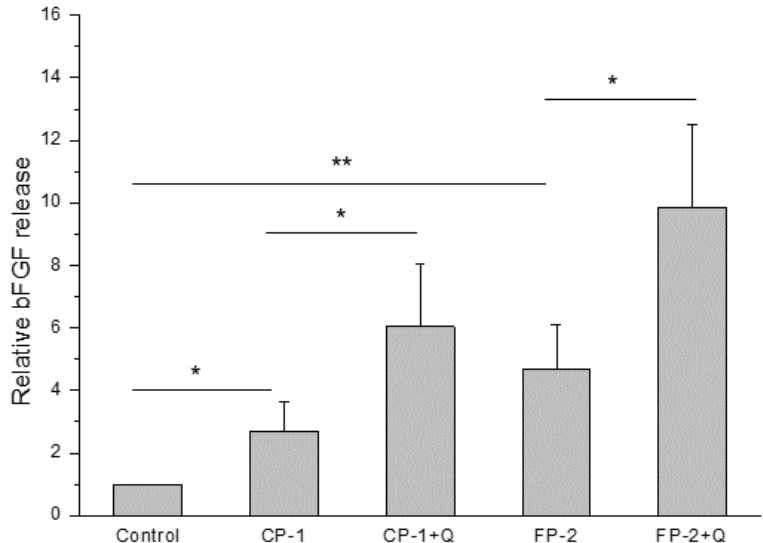
Figure 2. Release of basic fibroblast growth factor (bFGF) after 40 min from fresh HAM samples (Control) and thawed HAM, previously preserved with CP-1 or FP-2 in the presence (CP-1 + Q and FP-2 + Q) or not (CP-1 and FP-2) of quercetin. Data are expressed as fold change bFGF pg/mL related to control and are represented as mean ± SD of 3 independent experiments. * p < 0.05 and ** p < 0.01 between the indicated bars.